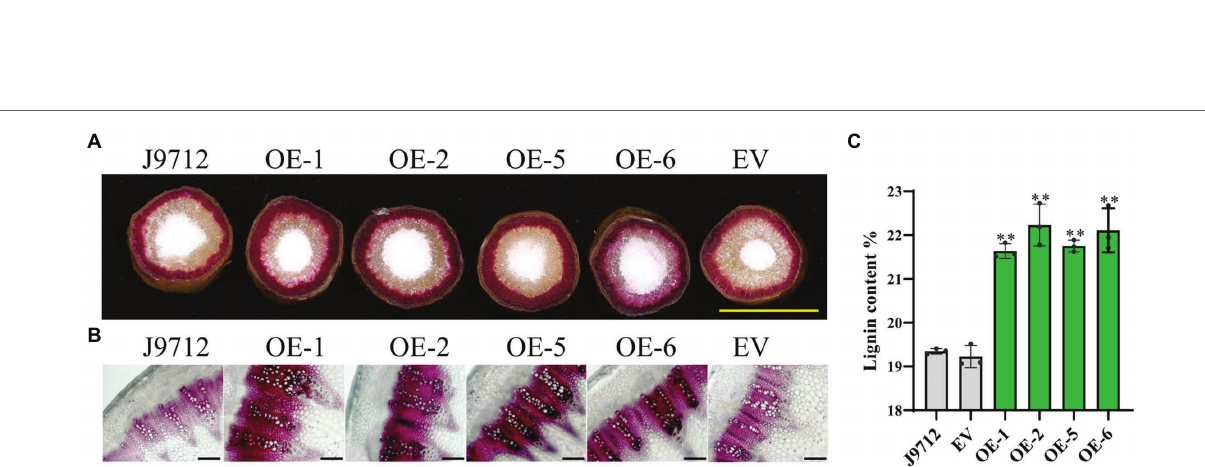
FIGURE 4 | Assessment of the disease resistance of BnaC.CCR2.b overexpression lines against S. sclerotiorum by stem inoculation in the field. (A) Representative images of disease lesions on the stems of OE-6 lines in T 2 generation at 7 dpidays post-inoculation Bar = 1 cm. (B,C) Stem lesion length in T 2 (B)- and T 3 (C)- generation transgenic plants at 7 dpi. The values are presented as the means ± SDs ( n = 25–30 in T 2 and T 3 ). The asterisks indicate significant differences between the overexpression transgenic lines and the J9712 lines ( * p < 0.05; ** p < 0.01; and Student’s t-test). (D) Representative images of disease lesions on the stems at 20 days post-inoculation.